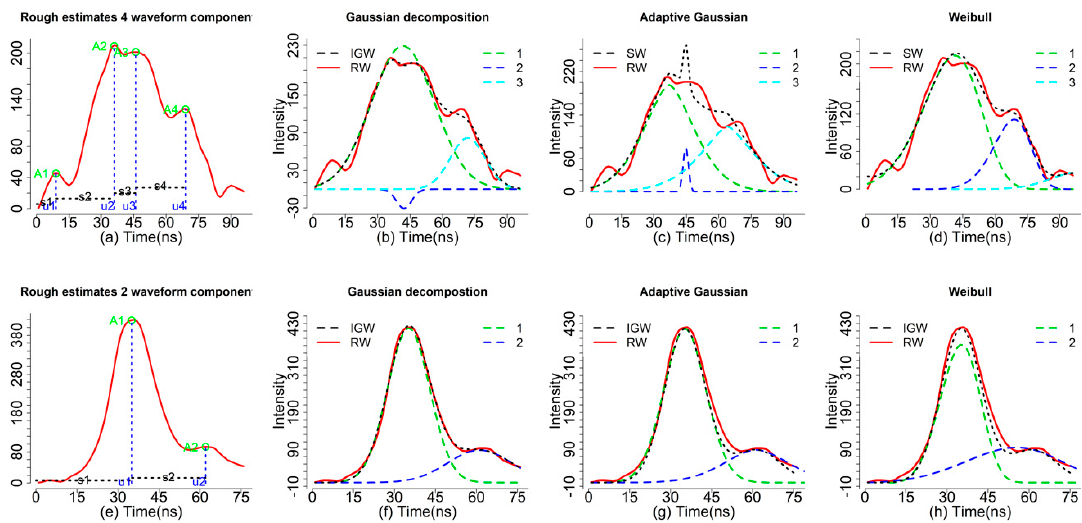
Figure 2. Comparisons of results using different waveform processing methods such as rough estimates the peakfind function ( a , e ), Gaussian ( b , f ), Adaptive Gaussian ( c , g ) and Weibull decompositions ( d , h ) for two representative waveforms. Black dash is the ideal model (Gaussian, Adaptive Gaussian and Weibull) based waveform (IGW), red solid is the raw waveform (RW). The number such as 1 2 or 3 represents the individual waveform components with different colors.